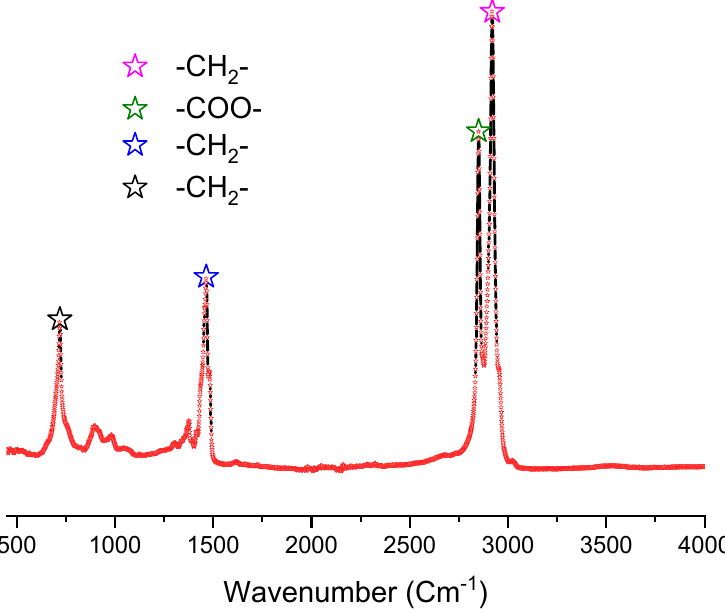
Figure 3. FTIR of the obtained molybdenum octahedral cluster complex Mo OHCs.